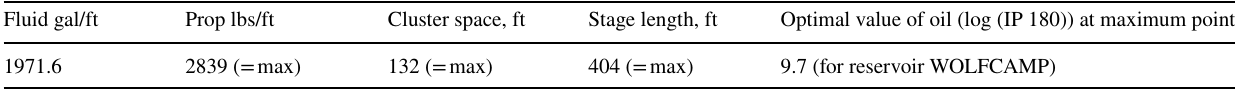
Table 4 Coordinates of the optimum point in the data region Fluid